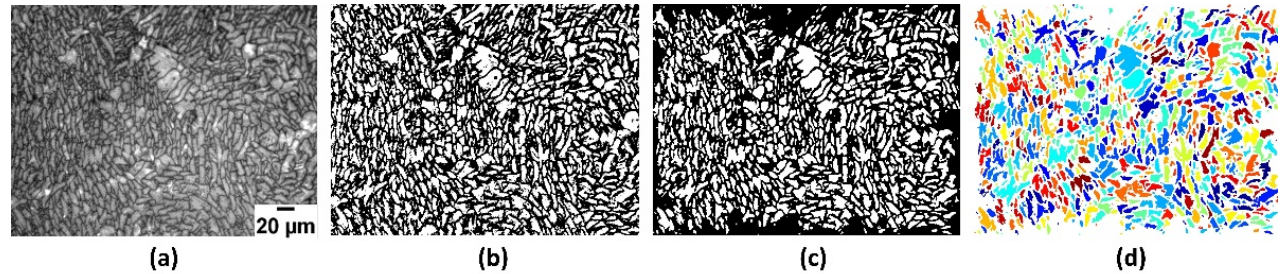
Figure 2. Illustration of all steps performed for image analysis for measuring pore size distribution with the inhouse MATLAB Code: ( a ) original gray scale image; ( b ) binarization; ( c ) morphological operations; ( d ) labelled watershed image.